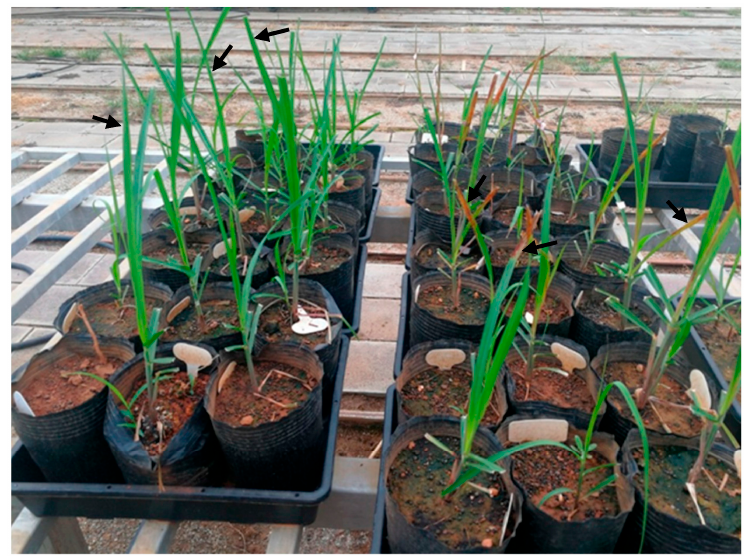
Figure 4. Leaves coated with 0.1% Basta after transplanting. Transformed sugarcane lines are on the left, and NT lines are on the right. The black arrows indicate differences between transformed and NT lines.